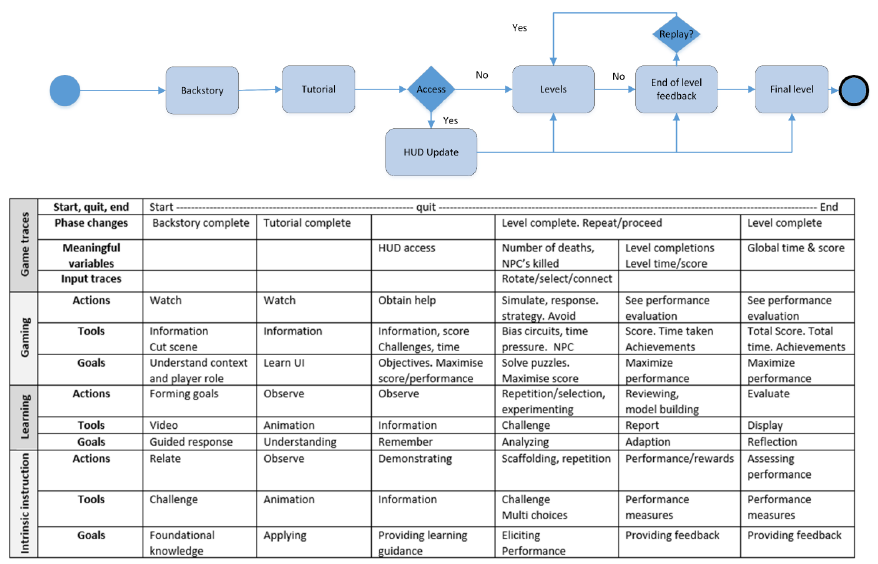
Fig. 7. Extended game sequence for Circuit Warz with game traces layers